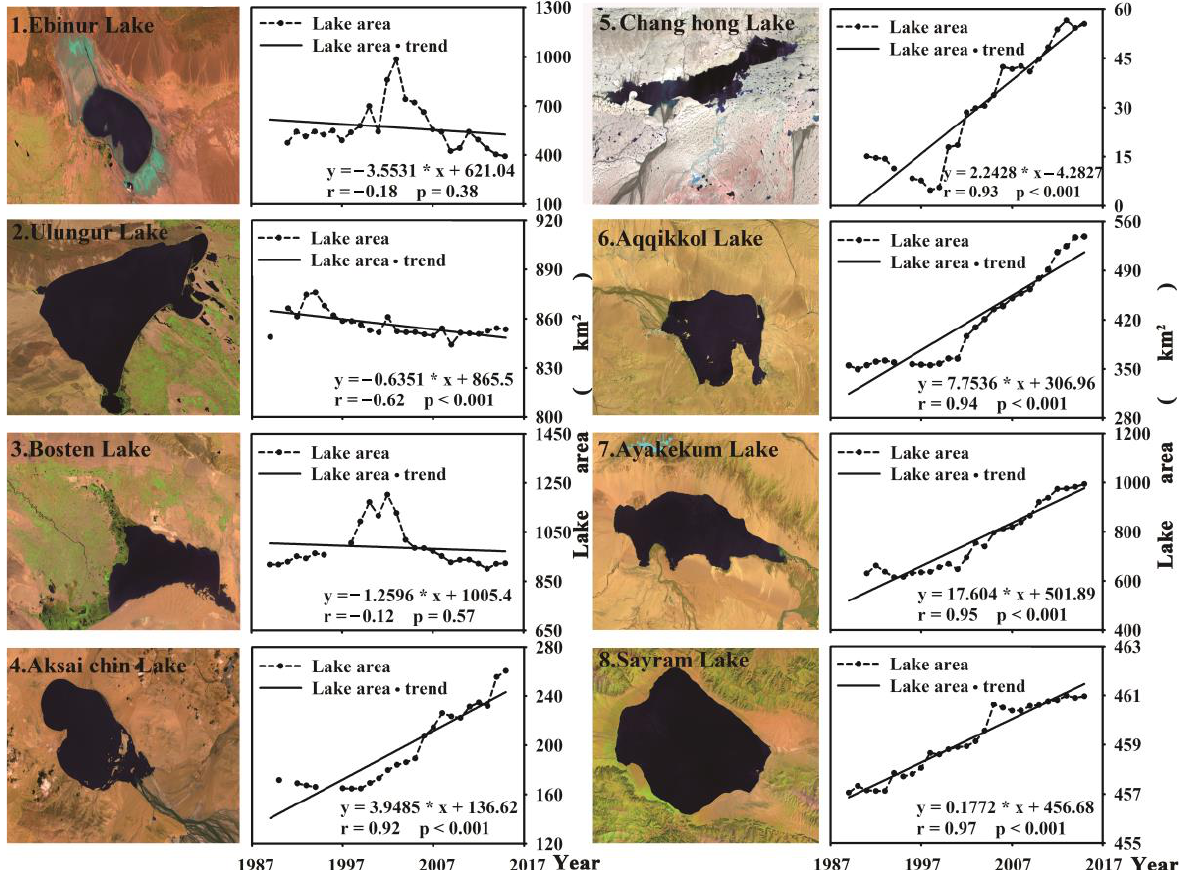
Figure 3. From 1989 to 2015: lake area changes of typical lakes.